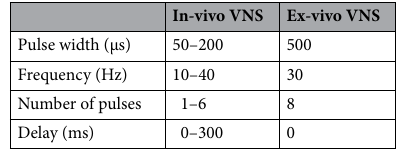
Table 1. VNS stimulation parameters applied in-vivo and ex-vivo.